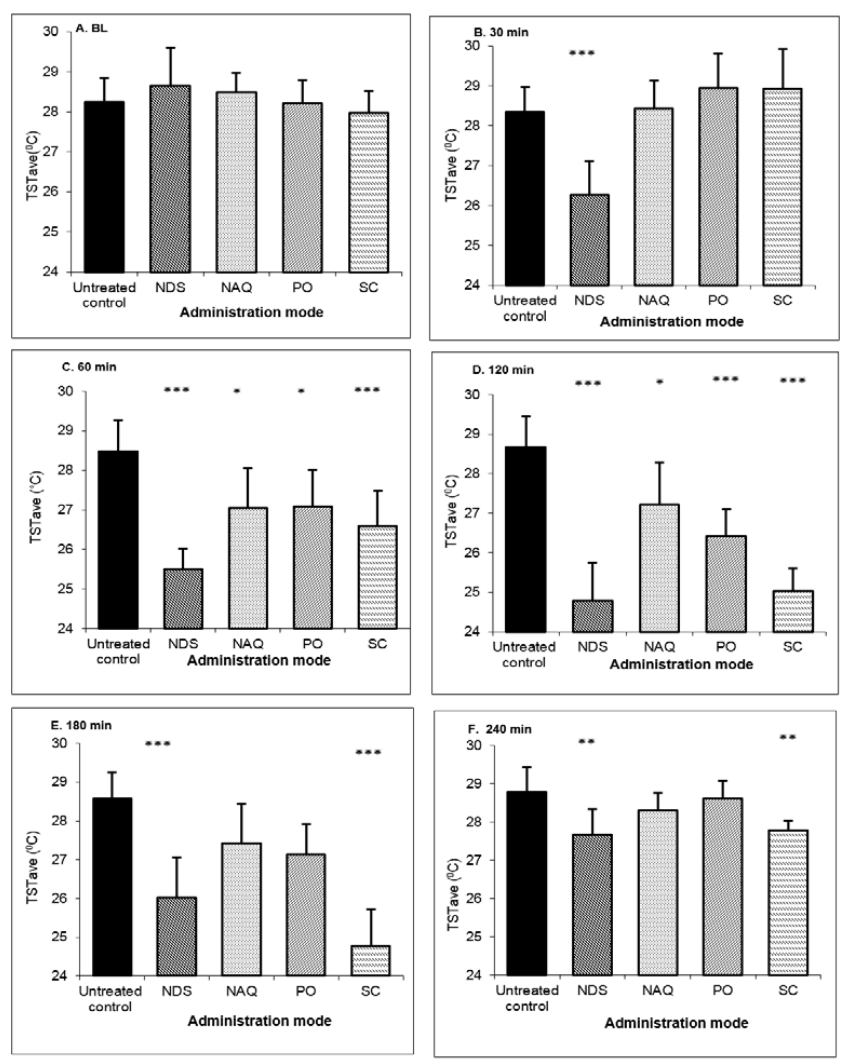
Figure 5. TST average values after buspirone NDS administration to OVX rats at dose 3 mg/kg compared to nasal aqueous solution (NAQ), oral administration (PO) and subcutaneous injection (SC) and in untreated control at: ( A ) baseline (BL); ( B ) 30 min; ( C ) 60 min; ( D ) 120 min; ( E ) 180